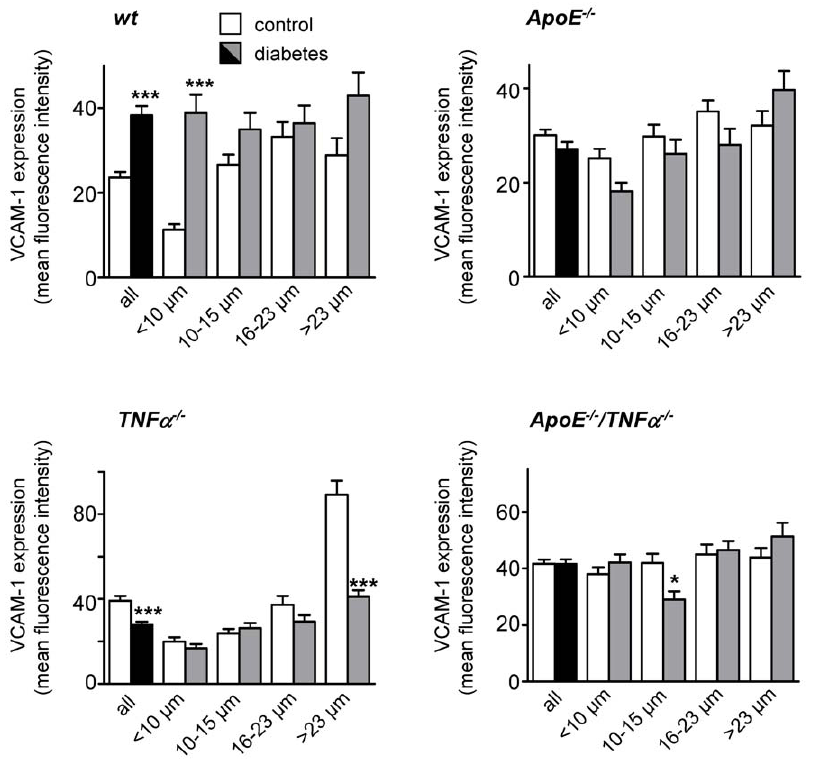
Figure 2. The effect of diabetes on VCAM-1 expression is dependent on retinal vessel size. Summarized data from confocal immunofluorescence microscopy experiments showing mean fluorescence intensity of VCAM-1 in retinal vessels divided into quartiles depending on vessel diameter ( , 10 m m, 10–15 m m, 16–23 m m and . 23 m m). Each graph represents the expression-diameter relationship in the different genotypes. White bars are for control and grey bars for diabetes. The two first bars in each graph (in white and black, for control and diabetes respectively) show the same data as in Figure 1 , but are displayed here as references. * p , 0.05 and *** p , 0.001 indicate differences between control and diabetes of the same size and